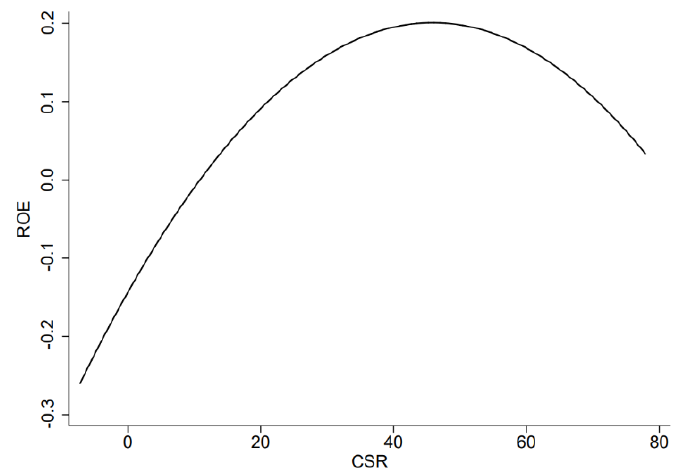
Figure 1. The U-shaped relationship between CSR and CFP.